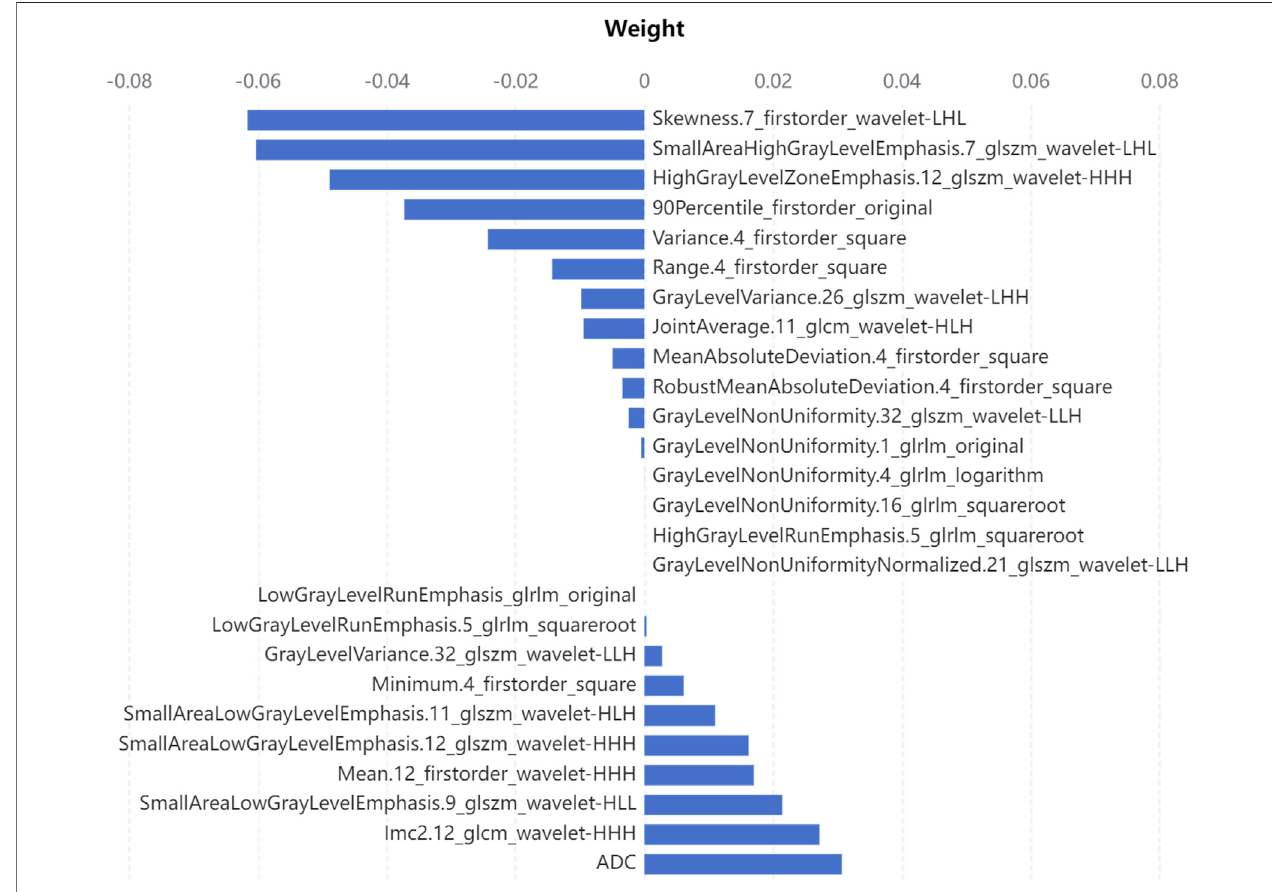
FIGURE 5 | Weight of selected features with Lasso in the linear regression classi fi er.